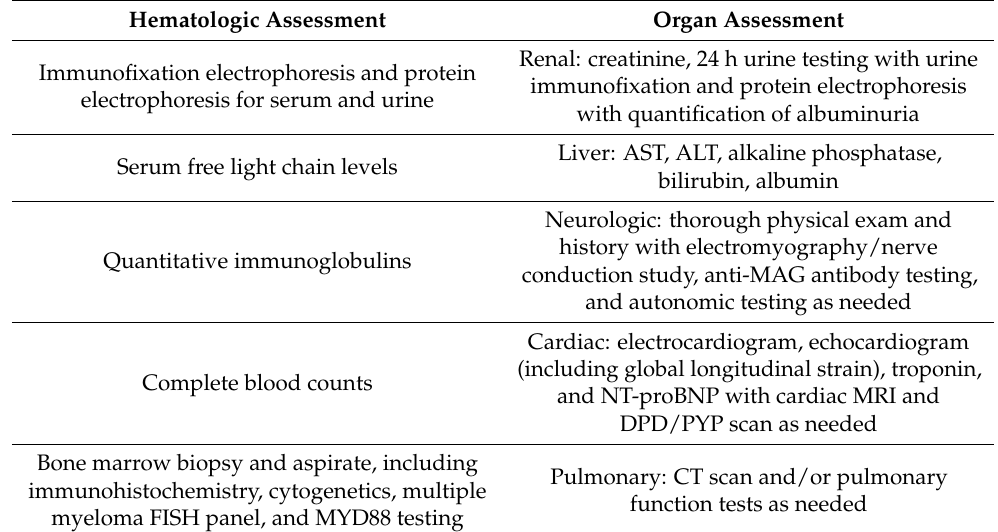
Table 1. Recommended initial hematologic and organ assessment in IgM-related amyloidosis. Hematologic Assessment Organ